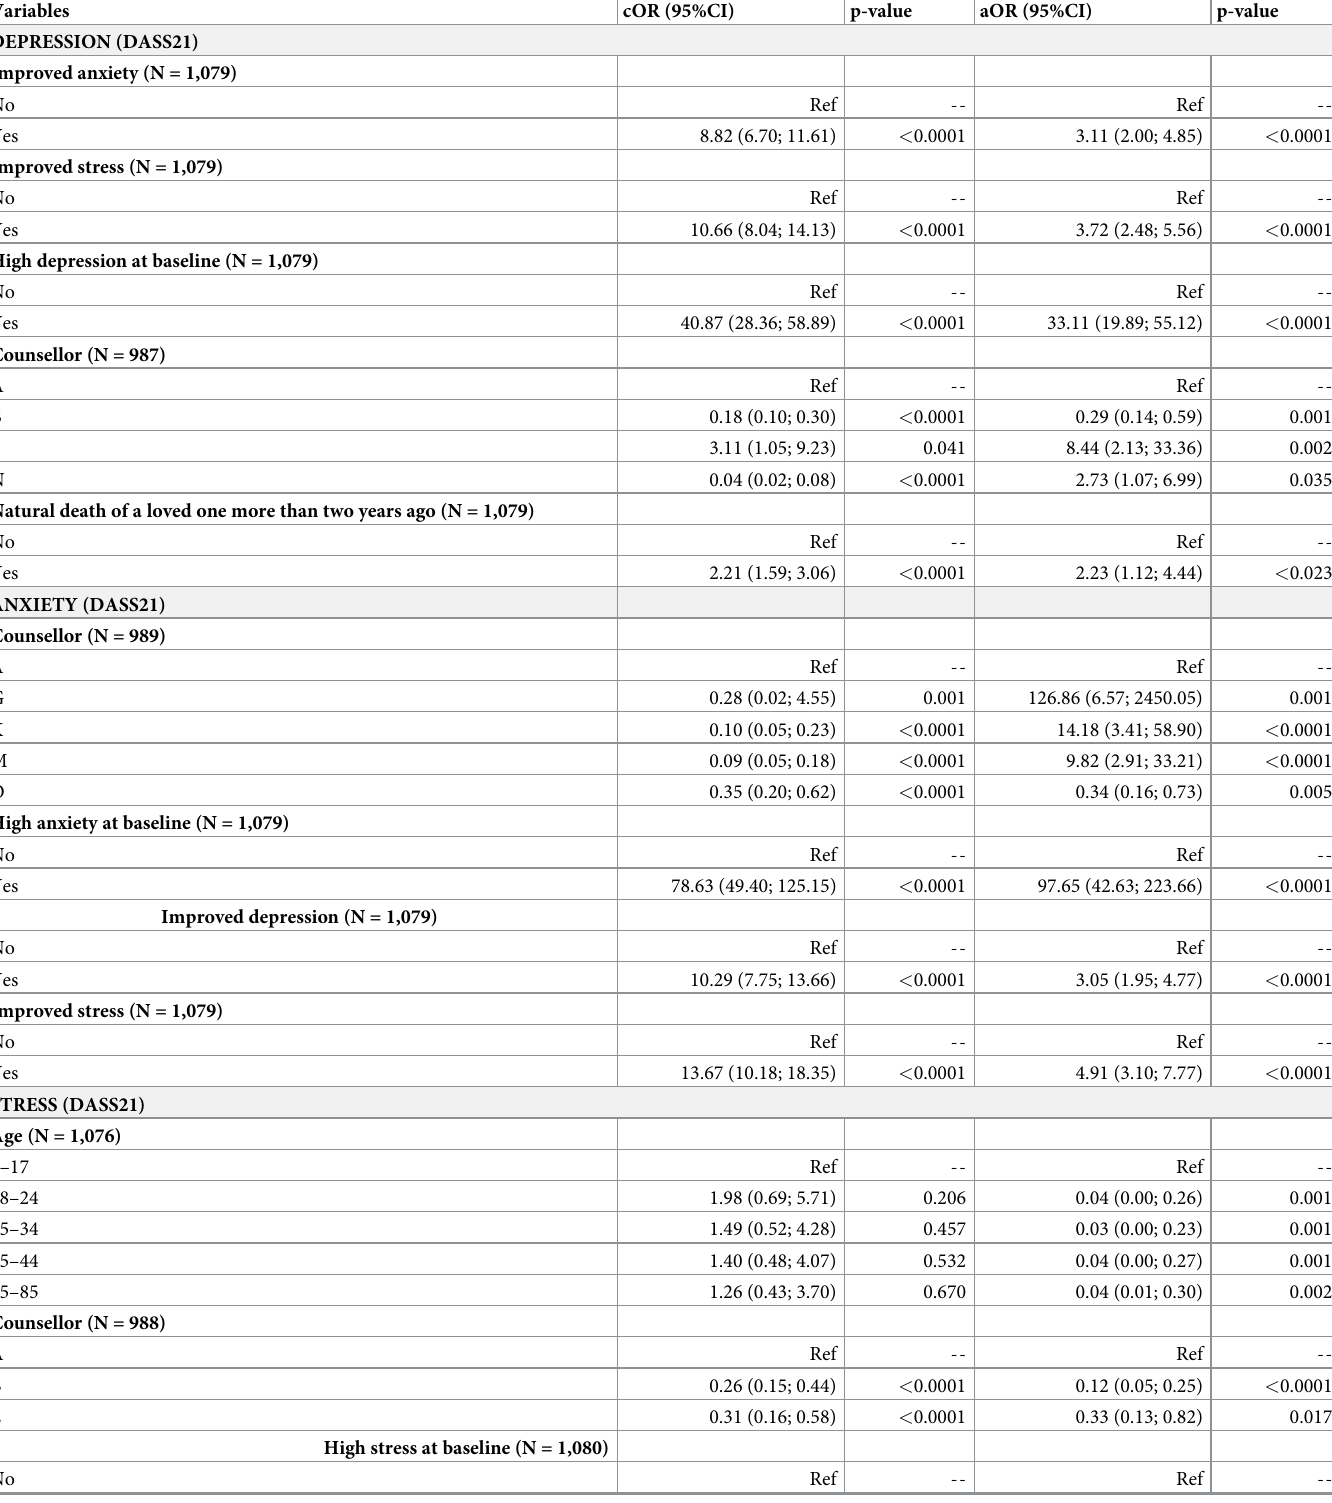
Table 5. Factors associated with improved distress and functioning following MHPSS (cOR: crude odds ratio, aOR: adjusted odds ratio, p-value from Wald